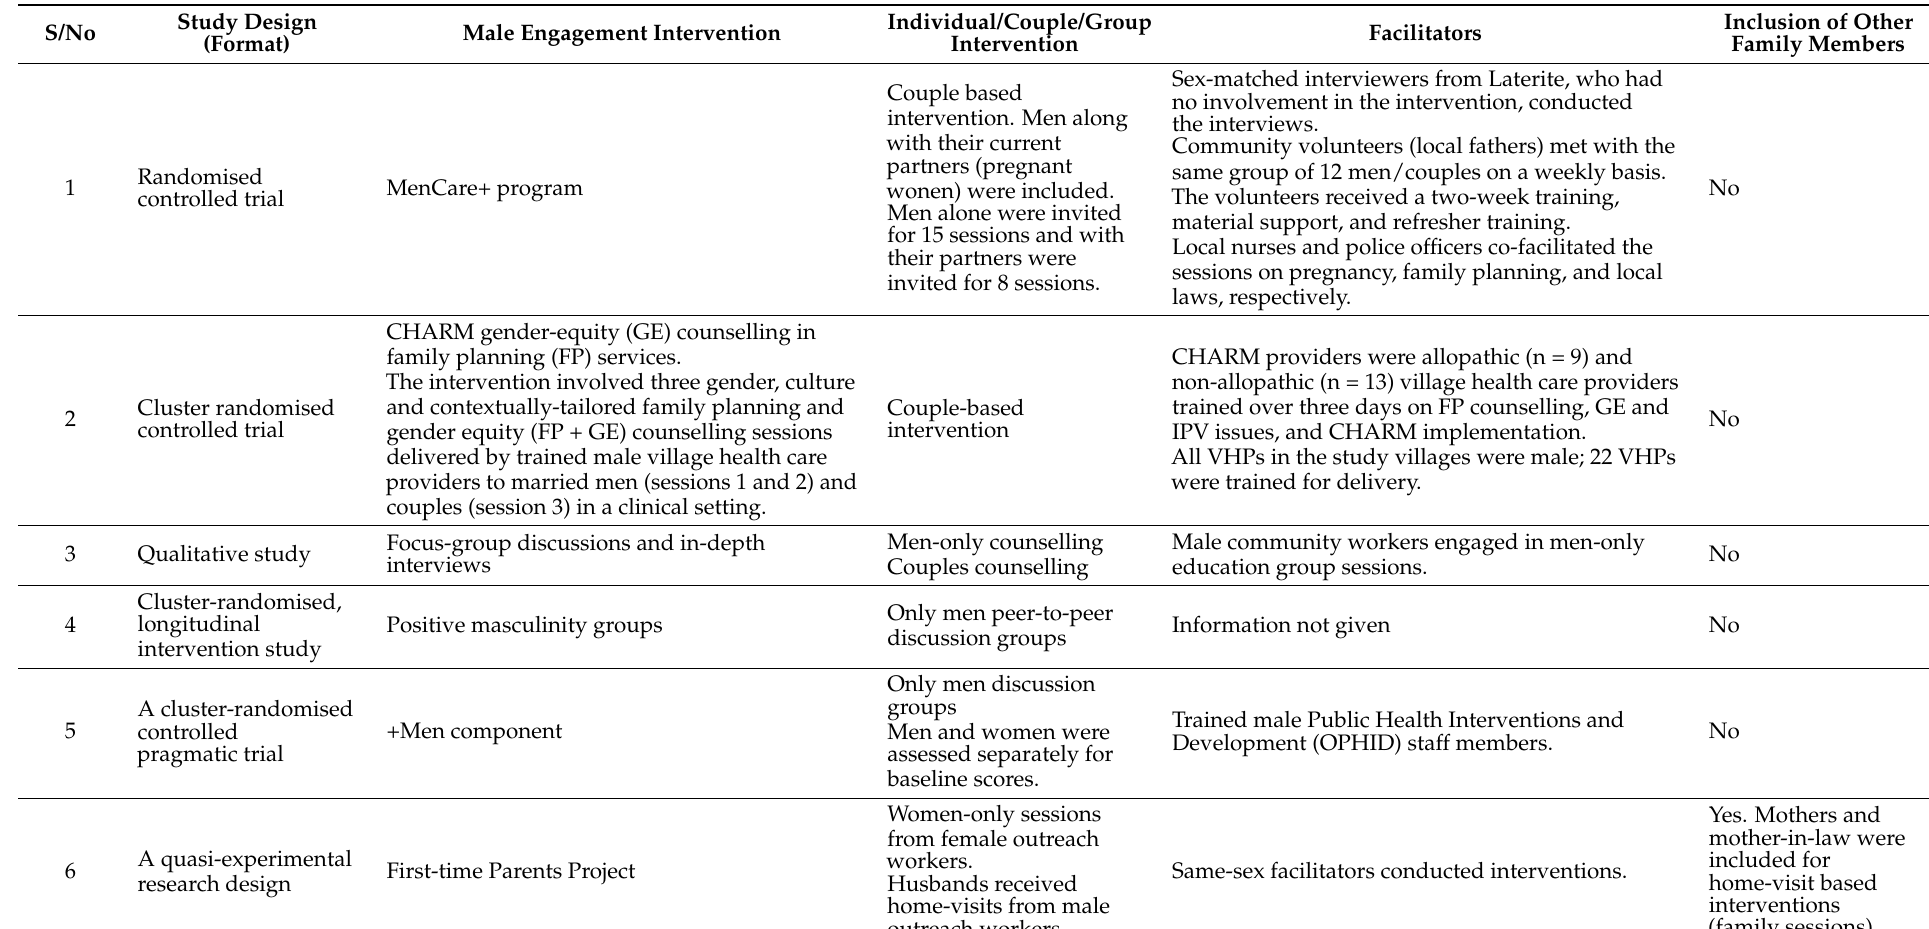
Table 2. Details of the facilitators and recipients of the